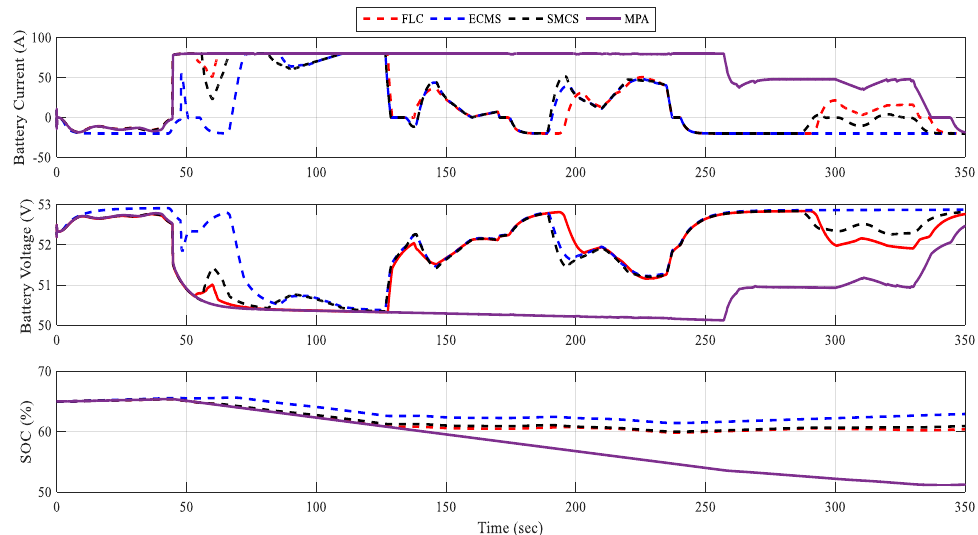
Figure 13. Time responses of the battery’s state of charge (SOC), current, and voltage.